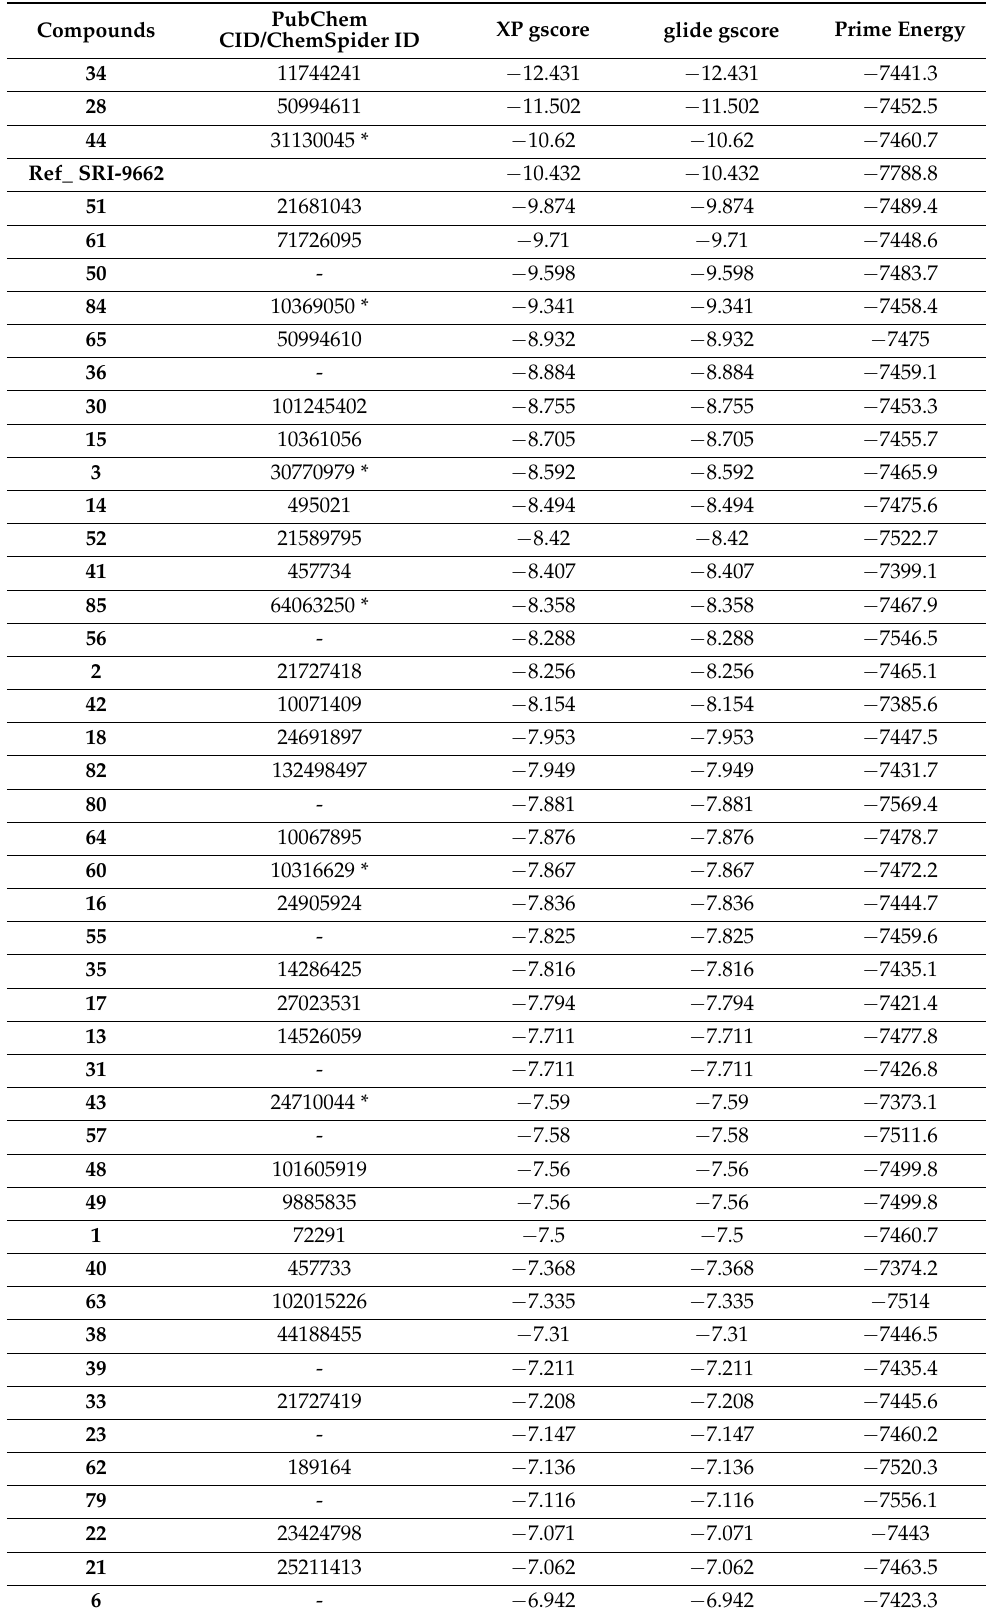
Table 2. In silico docking results of sesquiterpene metabolites with hDHFR (PDB: 1KMV) compared to the reference inhibitor SRI-9662